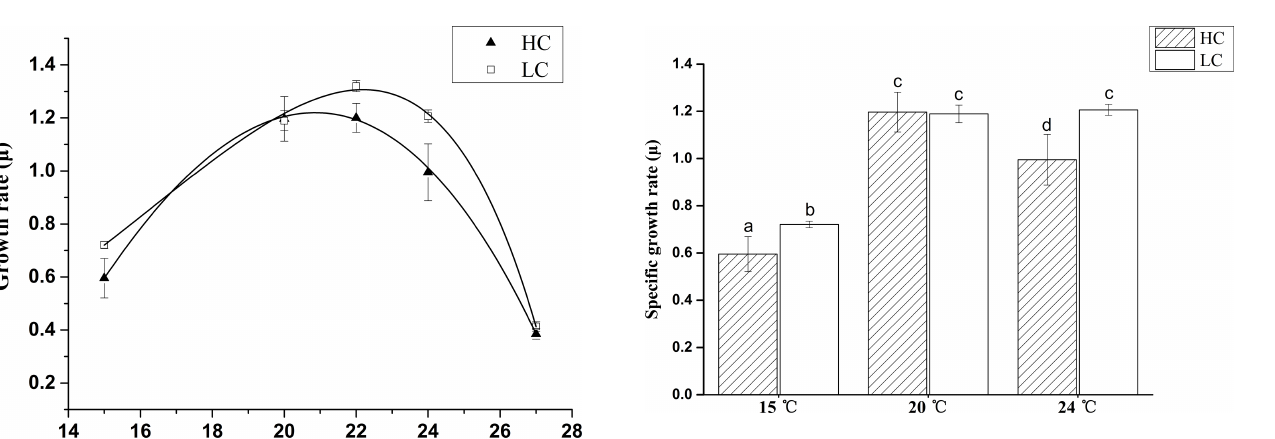
Figure 2. Specific growth rate of E. huxleyi grown in 400µatm (LC) and 1000µatm (HC) CO 2 concentrations at 15, 20 and 24 ◦ C, re- spectively. The different letters above the bars indicate significant differences among the treatments ( p < 0 . 05). The values are the means, and the error bars are standard deviations for triplicate cul- tures for each